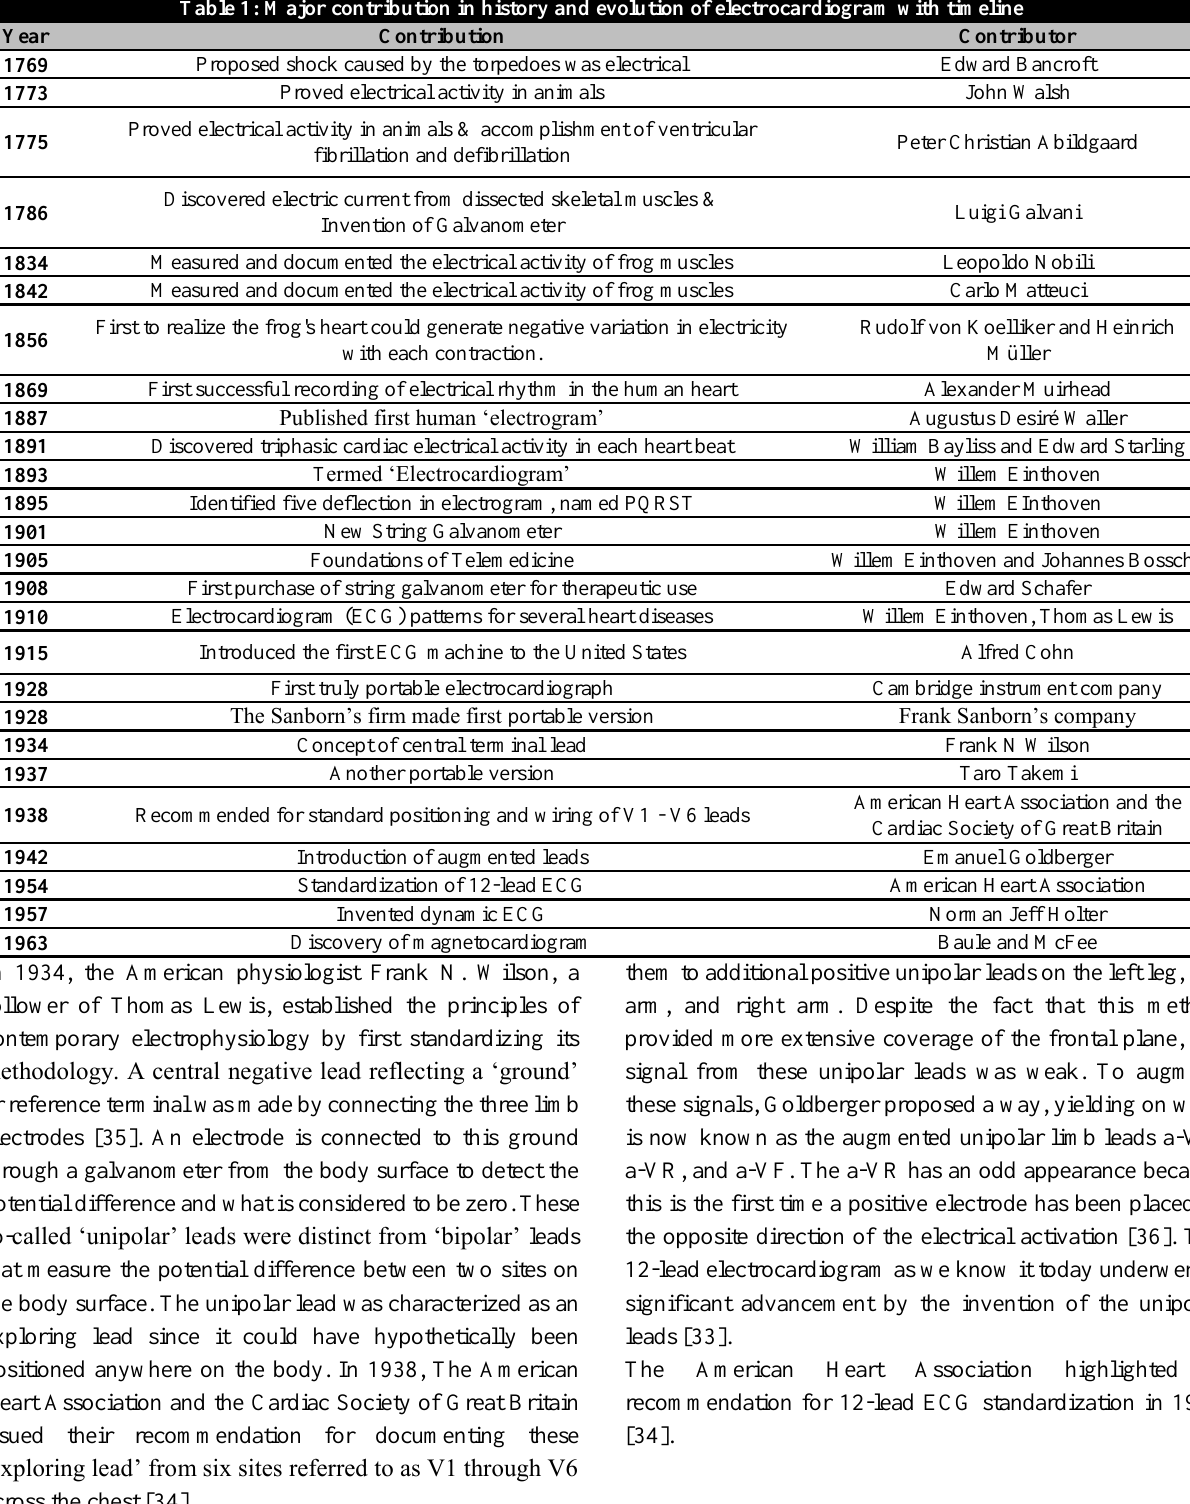
Table 1: Major contribution in history and evolution of electrocardiogram with